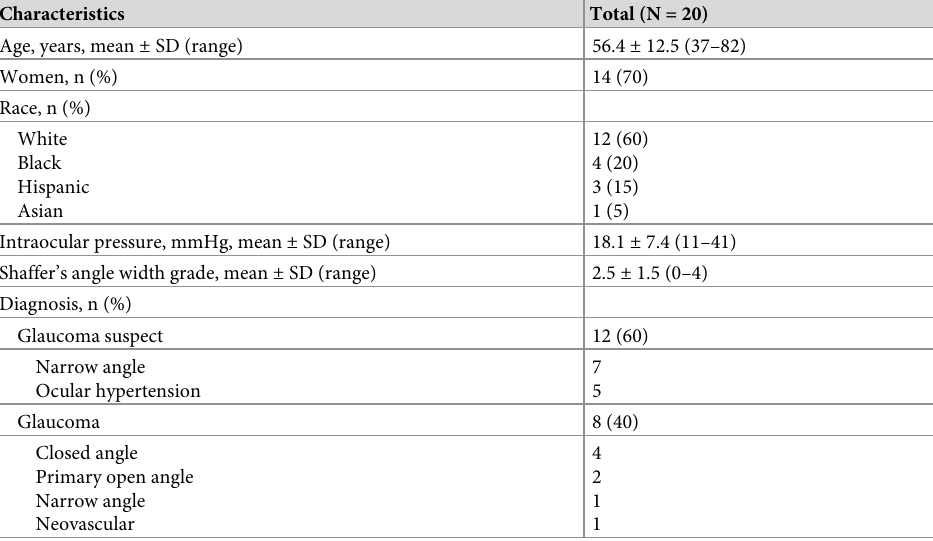
Table 1. Demographic and clinical characteristics of the study